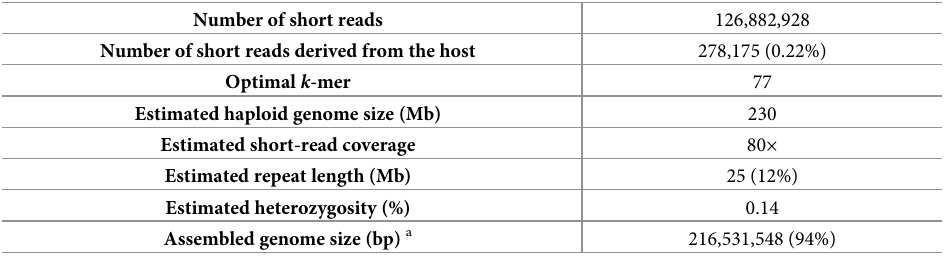
Table 1. Statistics from short-read Illumina paired-end sequencing of Cardicola forsteri .